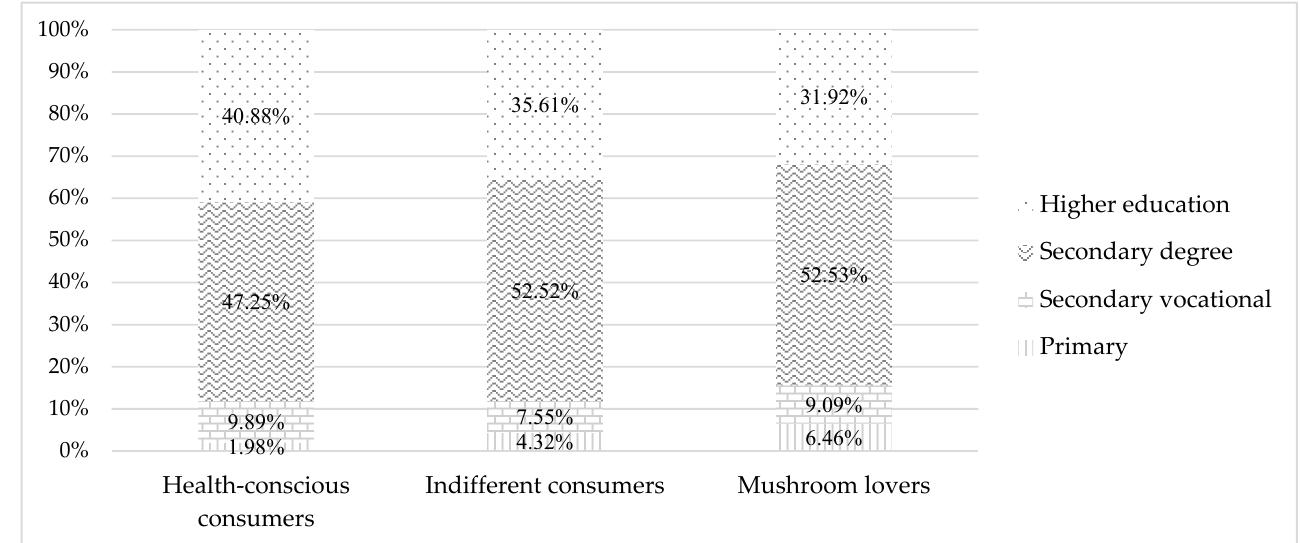
Figure 5. Age distribution within clusters generated based on the level of consciousness in mushroom consumption.